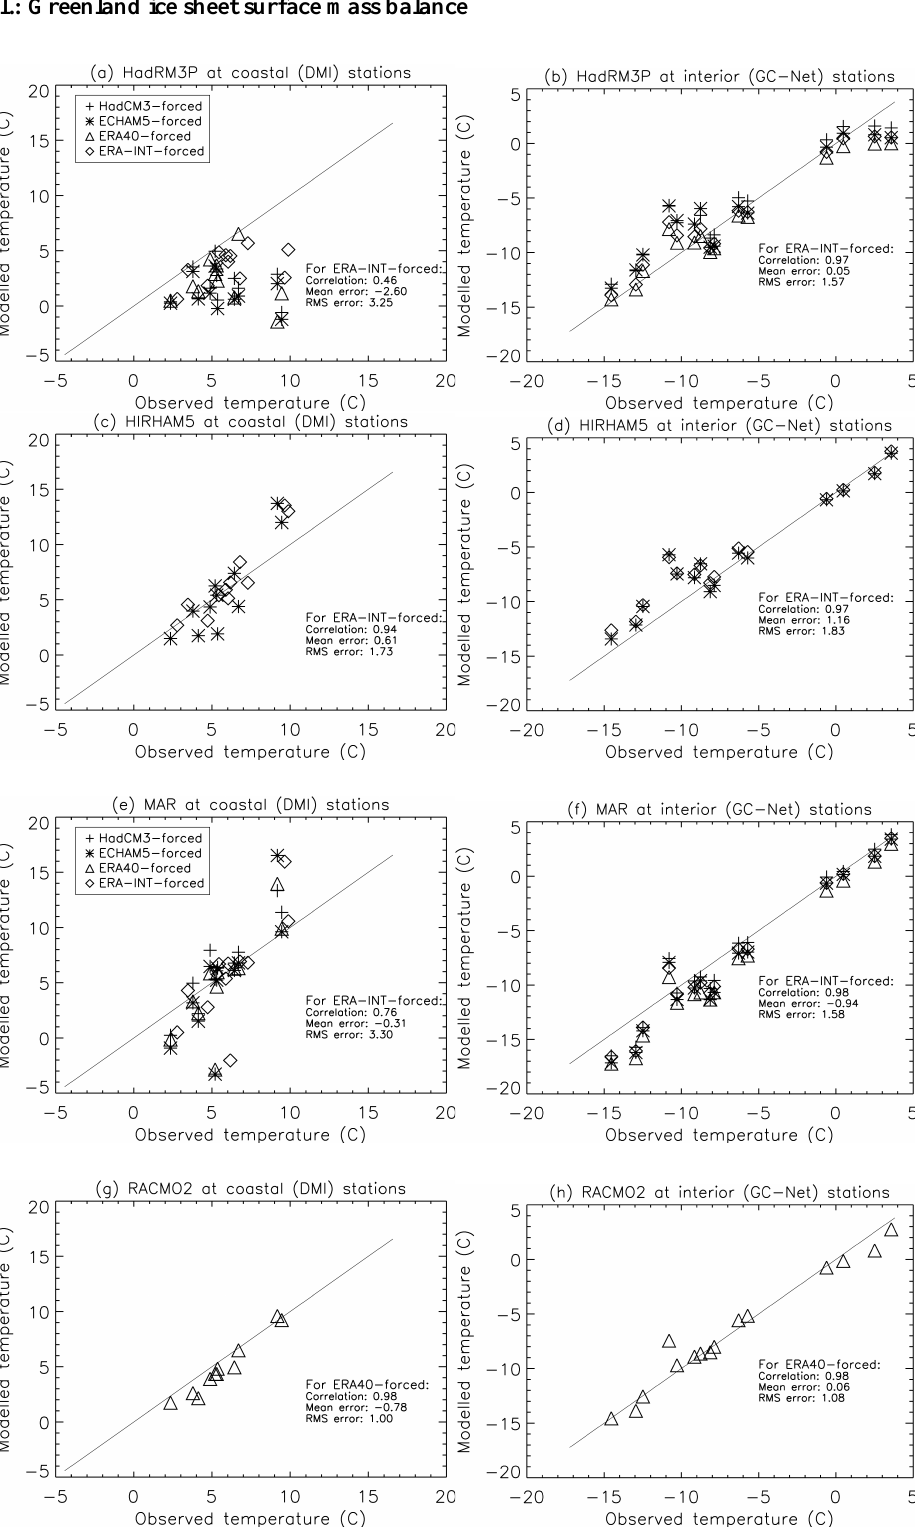
Fig. 2. 20-yr mean modelled versus observed summer (JJA) T as ( ◦ C). Each point represents an observing station. The line of 1:1 correspon- dence is also shown. The legend, given in (a) , is the same in all figures. Correlations between modelled and observed 20-yr mean T as , and the mean and RMSEs of the model output relative to observations, are also given for the ERA-Interim-forced HadRM3P, MAR and HIRHAM5 simulations, and the ERA40-forced RACMO2